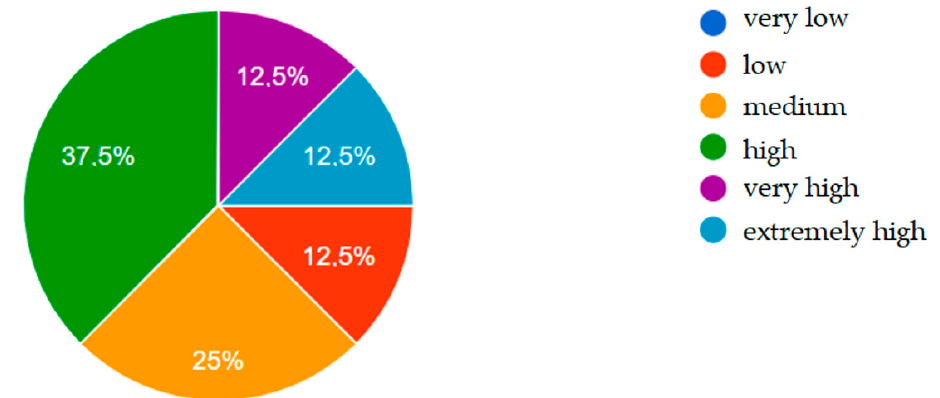
Figure 9. Estimated cost related to the elimination of a supply chain disruption.